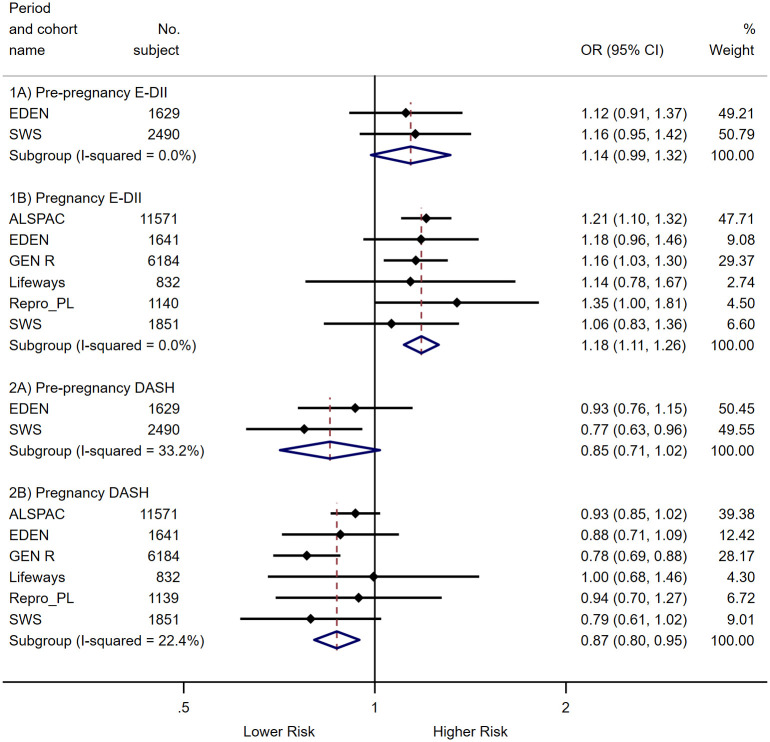
Forest plot showing adjusted associations of maternal E-DII and DASH scores (per 1-SD increase) during prepregnancy and pregnancy periods with risk of SGA.Black dots indicate study-specific point effect estimates with corresponding 95% CIs indicated by horizontal lines, and diamonds indicate the pooled estimates with their corresponding 95% CIs. As the ROLO study has estimates with very wide confidence intervals that impaired data visualization, it was excluded from this figure. By design, the ROLO study recruited mothers who have previously delivered a macrosomic infant, thus infants born low birth weight or SGA in this study were rare (<1%), causing unstable estimates. However, it should be noted that excluding this study did not affect the pooled estimates and overall conclusion [pooled OR (95% CI) = 1.18 (1.11, 1.26) for E-DII and 0.87 (0.80, 0.95) for DASH when ROLO was excluded cf. pooled OR (95% CI) = 1.18 (1.11, 1.26) for E-DII and 0.87 (0.82, 0.94) for DASH when ROLO was included]. When other studies were omitted one at a time for pregnancy E-DII and DASH meta-analysis, the overall pooled estimates were not affected and remained statistically significant: for E-DII: (range of ORs = 1.16–1.19, all CIs did not include 1); for DASH: (range of ORs: 0.82–0.92, all CIs did not include 1). Effect estimates were adjusted for maternal education, ethnicity, prepregnancy BMI, maternal height, parity, energy intake (for DASH), cigarette smoking and alcohol consumption during pregnancy, and child sex. BMI, body mass index; DASH, Dietary Approaches to Stop Hypertension; E-DII, energy-adjusted Dietary Inflammatory Index; OR, odds ratio; ROLO, Randomised cOntrol trial of LOw glycaemic index diet during pregnancy study; SGA, small-for-gestational-age.